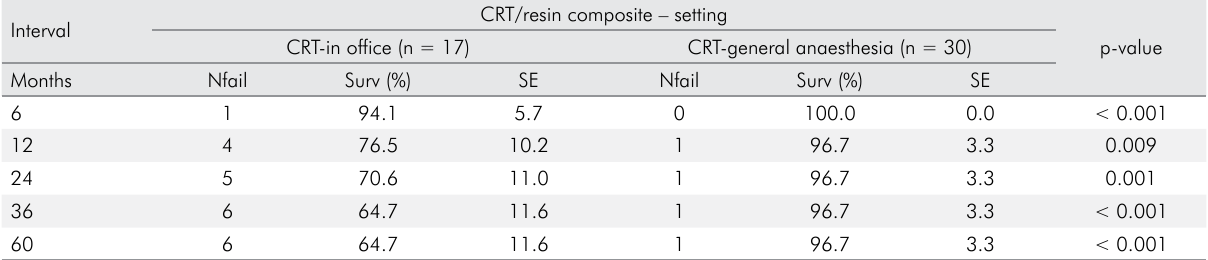
Table 4. Cumulative survival percentages and Jackknife standard error (SE) of CRT/resin composite restorations placed in permanent teeth of patients with disability after 5 years by setting.